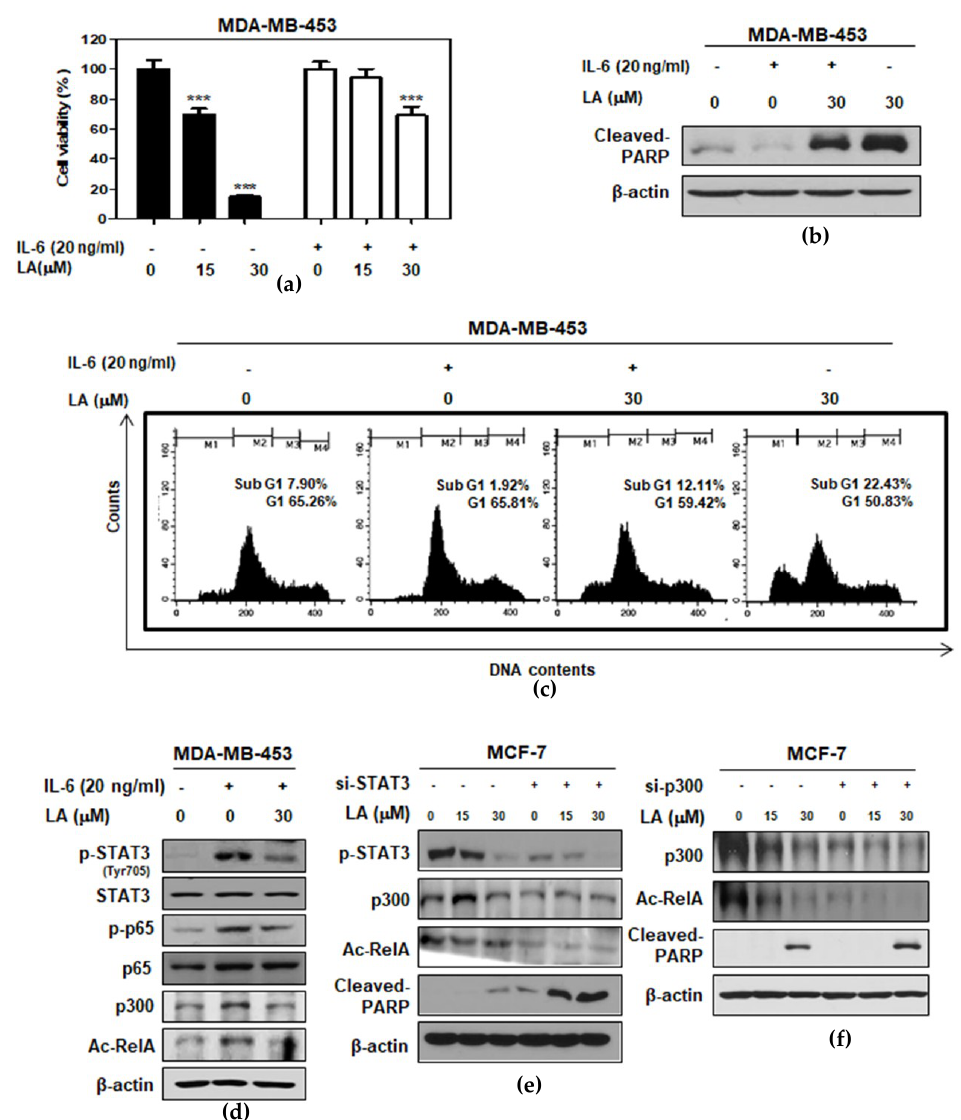
cells (Figure 4e,f).